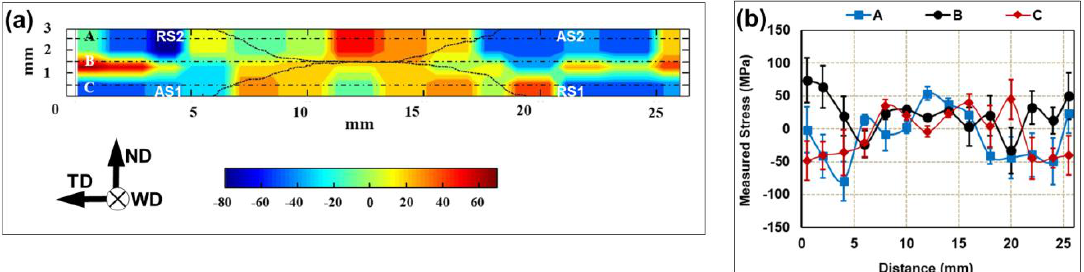
Figure 7. ( a ) Distribution of residual stress on the weld cross-section and ( b ) profiles of the residual stress measured along the lines indicated in ( a ). For clarity, the stir zone borderlines are outlined in ( a ) as dotted lines.